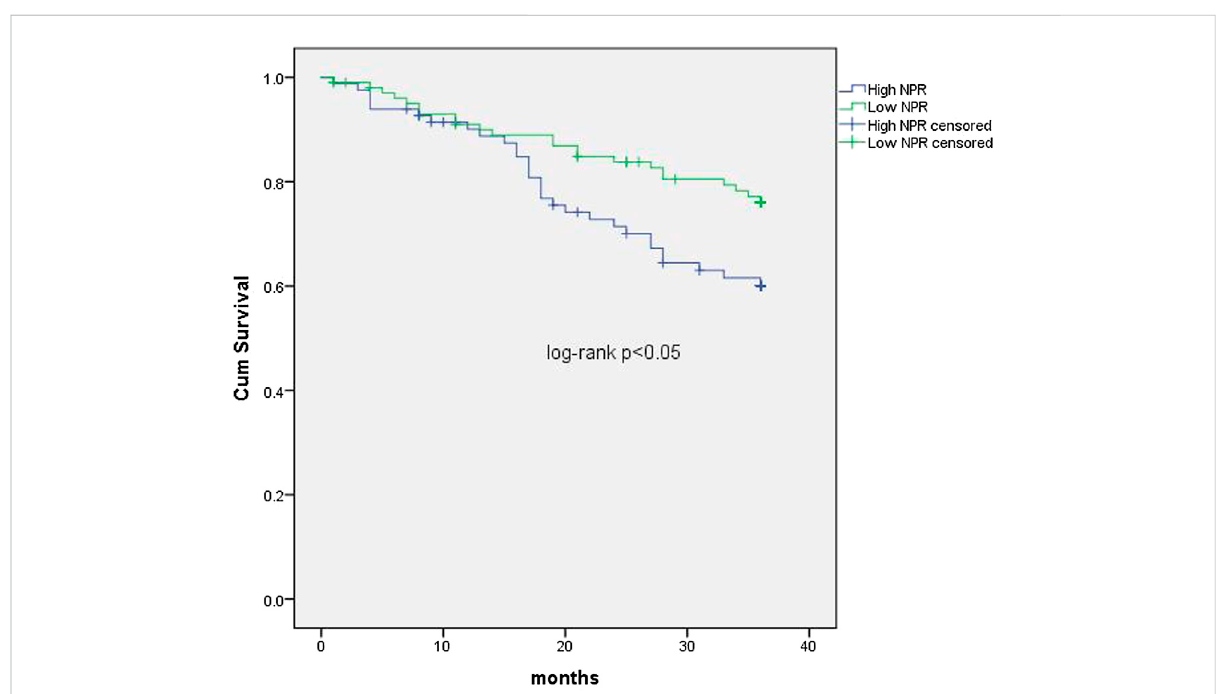
FIGURE 1 Kaplan-Meier curves comparing cumulative survival rates of patients with STEMI undergoing primary PCI in the low and high NLR ratio groups. NPR: neutrophil to platelet ratio.